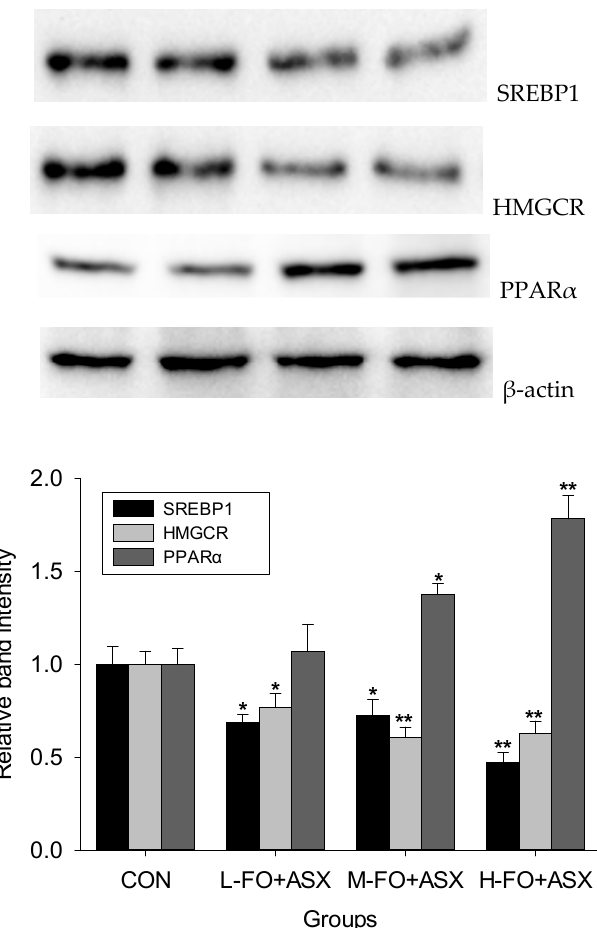
Figure 4. Effects of FO and ASX on hepatic lipid synthesis related proteins expression. Representative Immunoblot comparing relative SREBP1, HMGCR and PPAR α protein. CON: high-fat diet group; L-, M- and H-FO + ASX: low, moderate, and high FO and ASX groups. Bars represent means ± SEM from 4 independent experiments. * p < 0.05 and ** p < 0.01 compared to CON group.